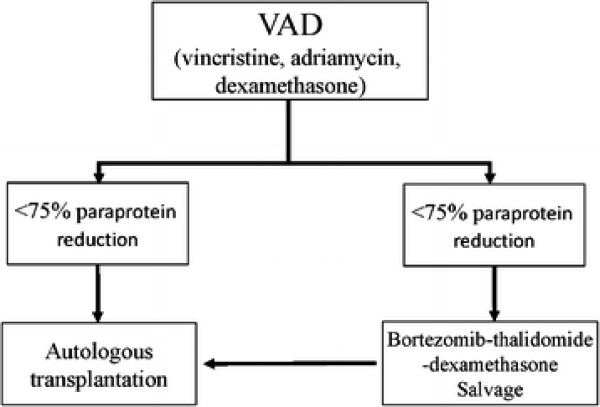
Staged Approach.